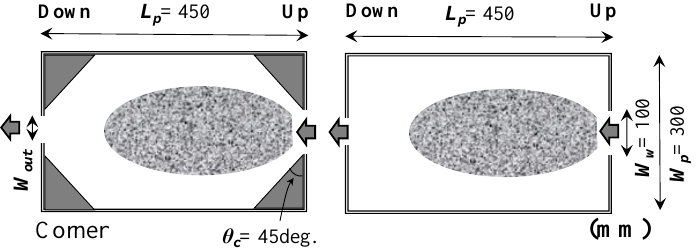
Figure 5. Sediment retarding basin plan view ( left : with corners, right : without corners).